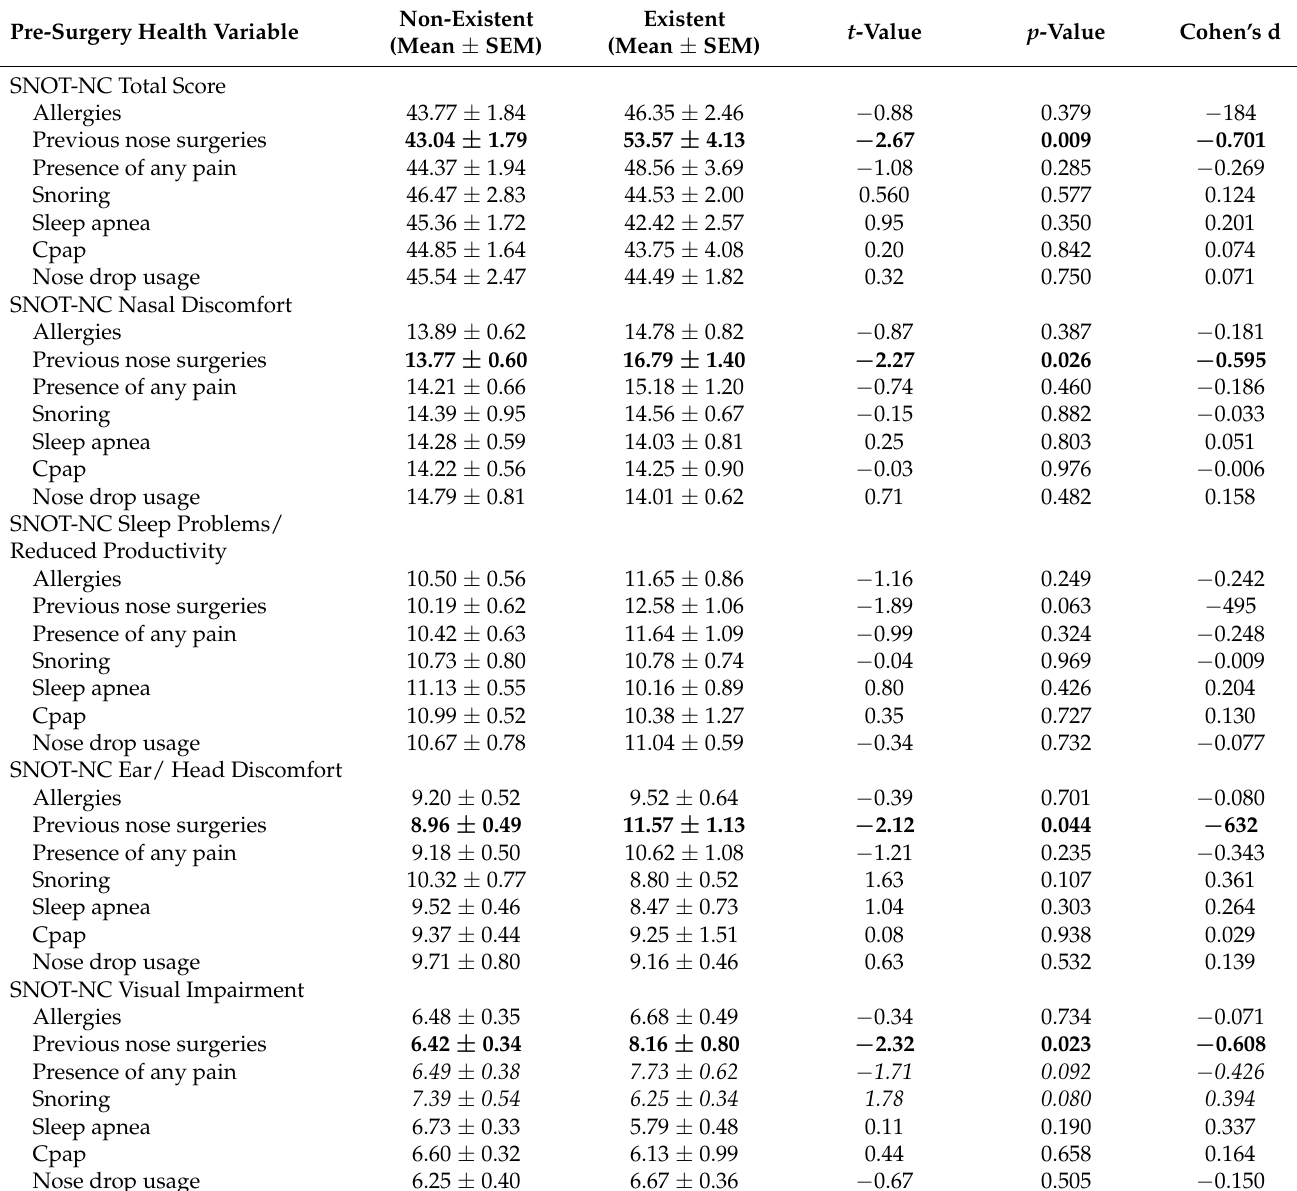
Table 1. SNOT-NC Scores based on pre-surgery health